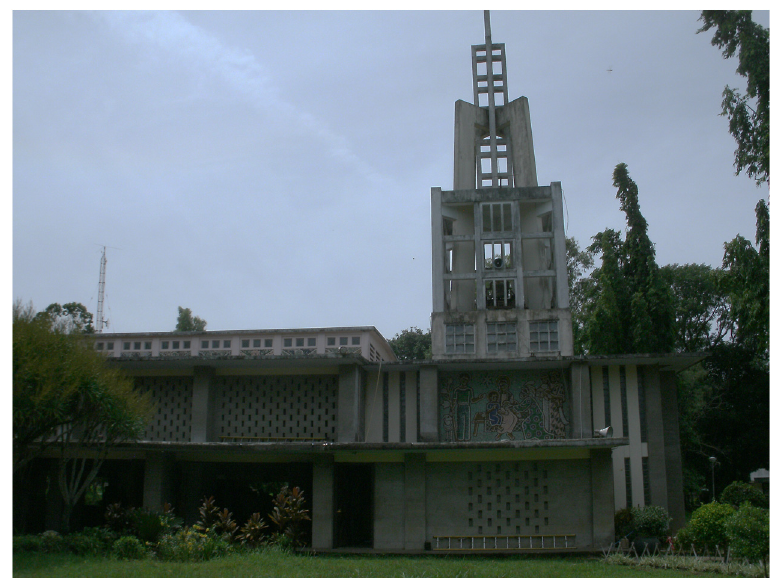
Figure 13. The Church of St. Joseph in Victoria, island of Negros (Philippines).